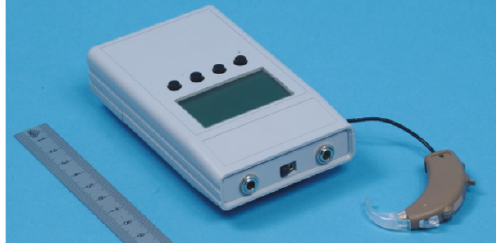
Figure 10: Photograph of the portable prototype real-time noise reduction